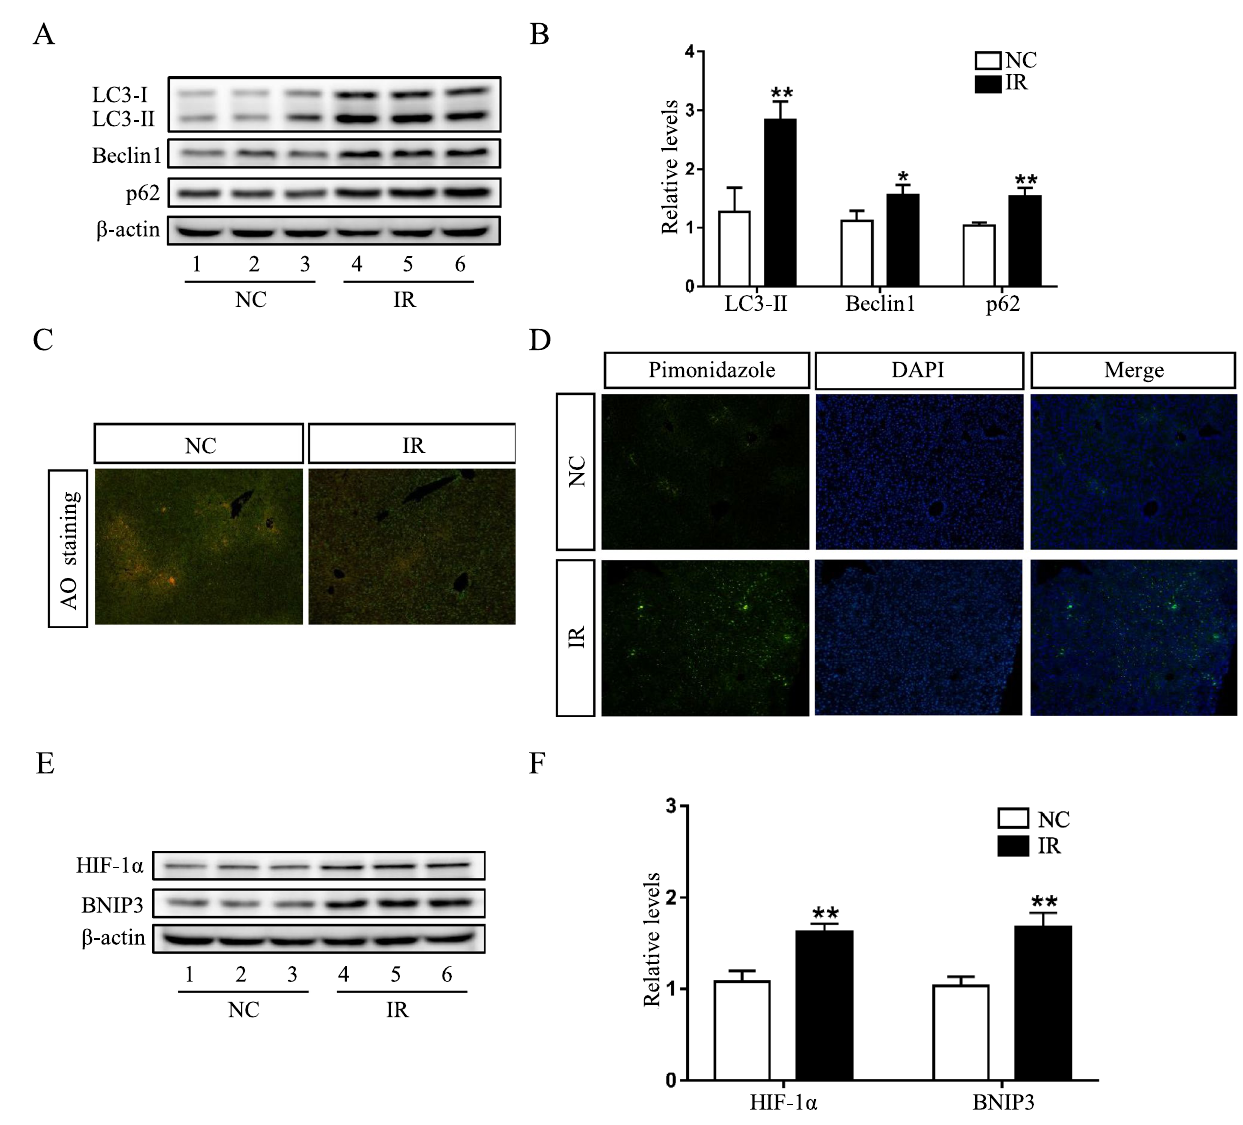
Figure 2. Impaired autophagic flux and activated HIF-1α/BNIP3 pathway are demonstrated in the liver of irinotecan (IR)-treated mice. ( A ) Western blot analysis of LC3-II, Beclin1 and p62 protein levels in liver tissue. ( B ) Densitometric quantification of LC3-II, Beclin1 and p62. ( C ) Effects of irinotecan on the formation of hepatic acidic vesicular organelles (orange) was examined by acridine orange (AO) staining. ( D ) Immunofluorescence was performed on liver sections using pimonidazole (green) to detect hypoxic regions, nuclei were stained with DAPI (blue). ( E ) Western blot analysis of HIF-1α and BNIP3 protein levels in liver tissue. ( F ) Densitometric quantification of HIF-1α and BNIP3. The blots were cut prior to hybridisation with indicated primary antibodies. Data are presented as mean ± SD (n = 6), * P < 0.05 and ** P < 0.01 compared with normal control (NC)